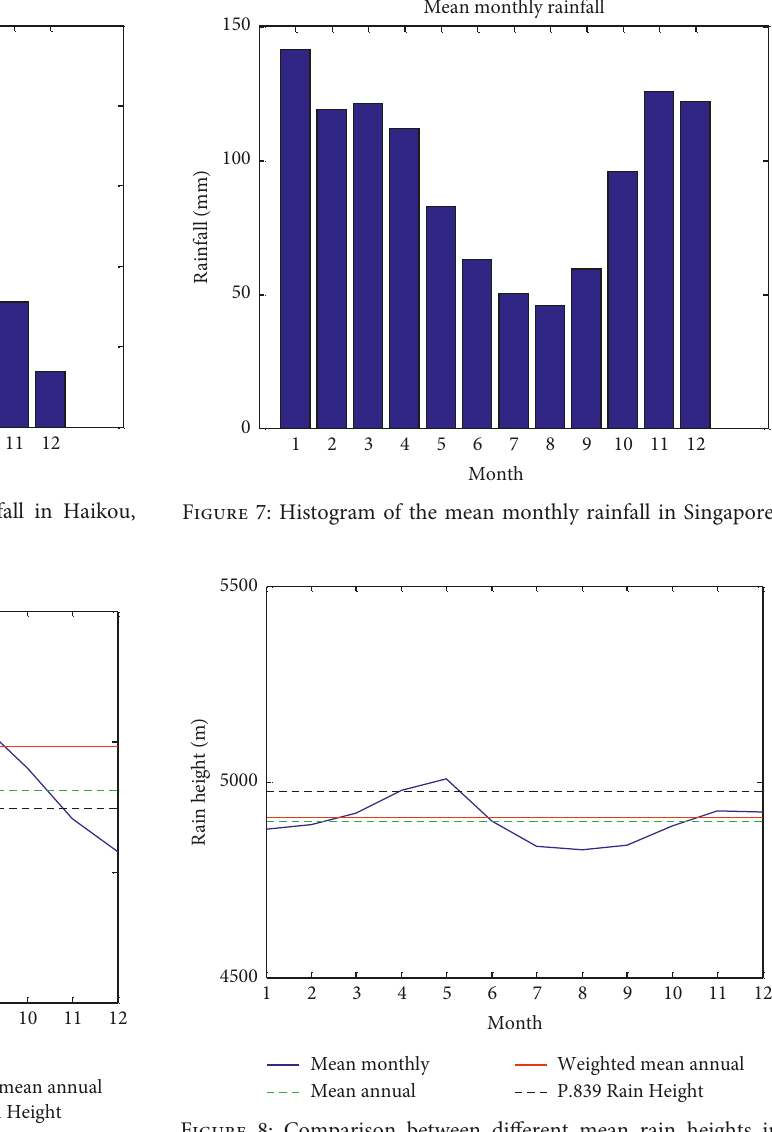
Figure 6: Comparison between different mean rain heights in Haikou, China.